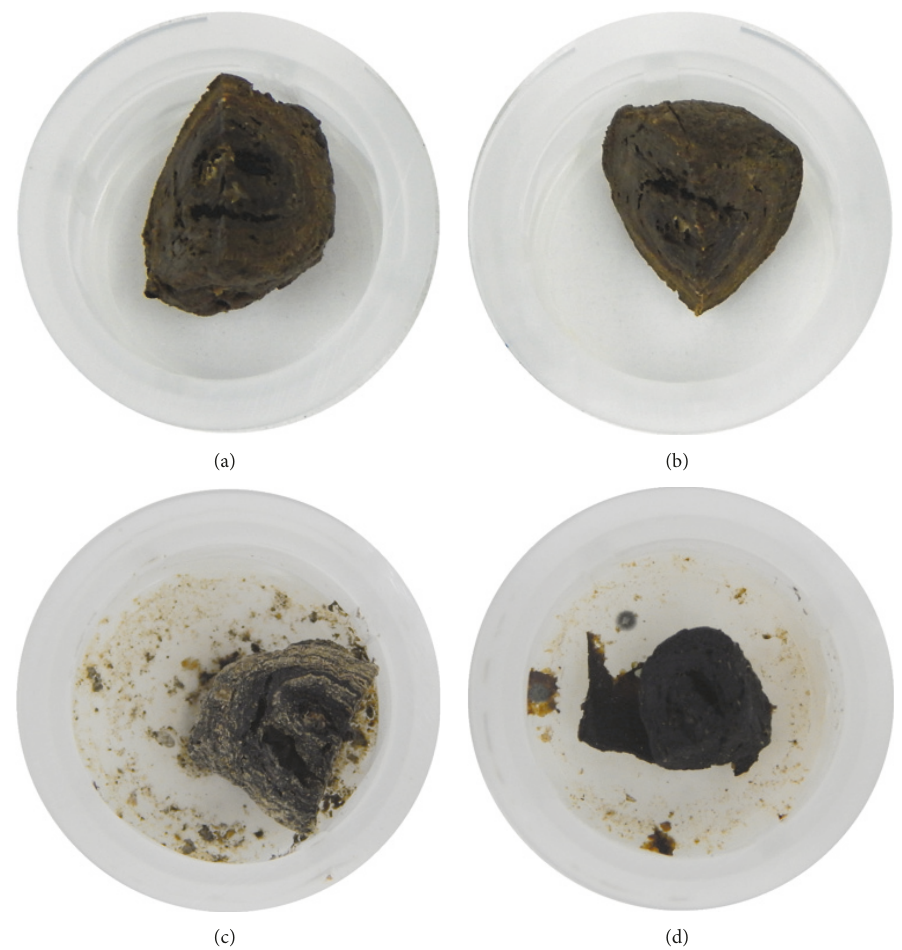
Figure 3: Photographs of the enterolith pieces. A piece before immersing in double distilled water (a) and a piece before immersing in 2% citric acid solution (b). After 120 hours of immersion and 30 minutes of air-drying, the color of the enterolith piece immersed in citric acid solution turned to black and appeared to have shrunken (d), compared with the piece immersed in water